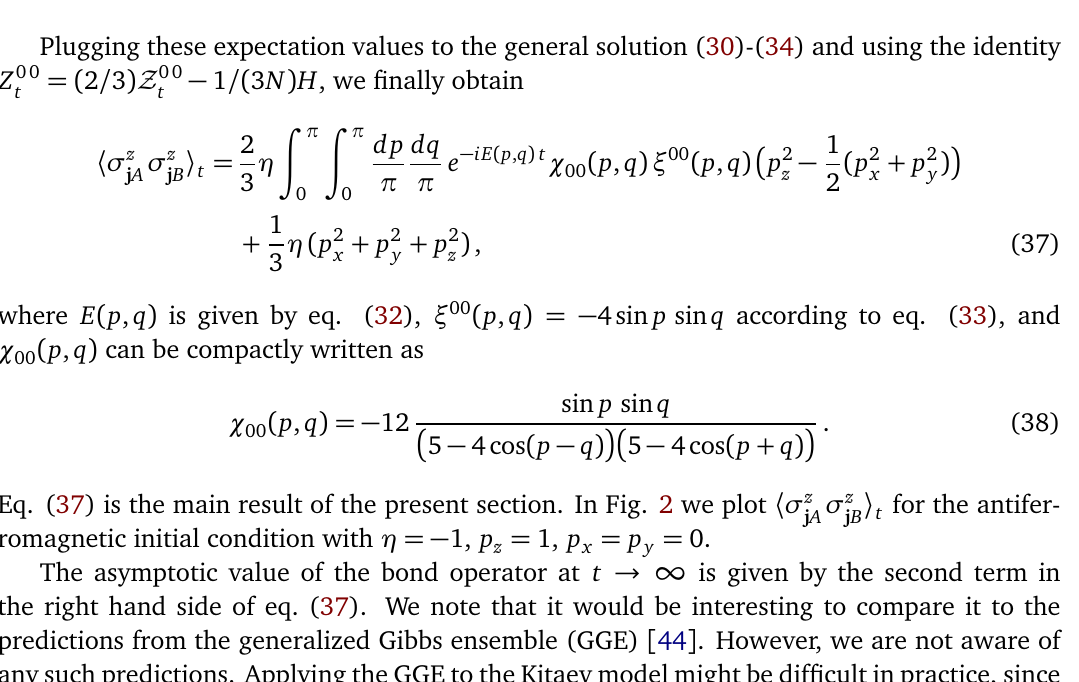
Figure 2: Expectation value of the bond operator for the antiferromagnetic product initial state polarized in the z -direction. Solid blue line – the analytical result of the present paper for the Bethe lattice, dashed magenta line – numerical calculations of ref. [ 34 ] for the hexagonal lattice. Dotted gray line marks the asymptotic value ( − 1 / 3 ) of the bond operator on the Bethe lattice at t → ∞